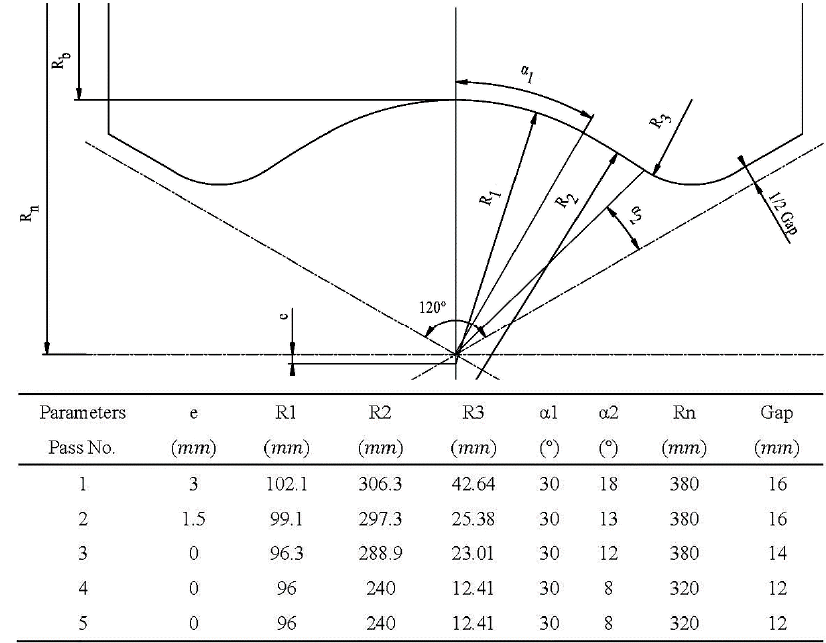
Figure 8. Geometry of grooved roll used in experimental rolling.